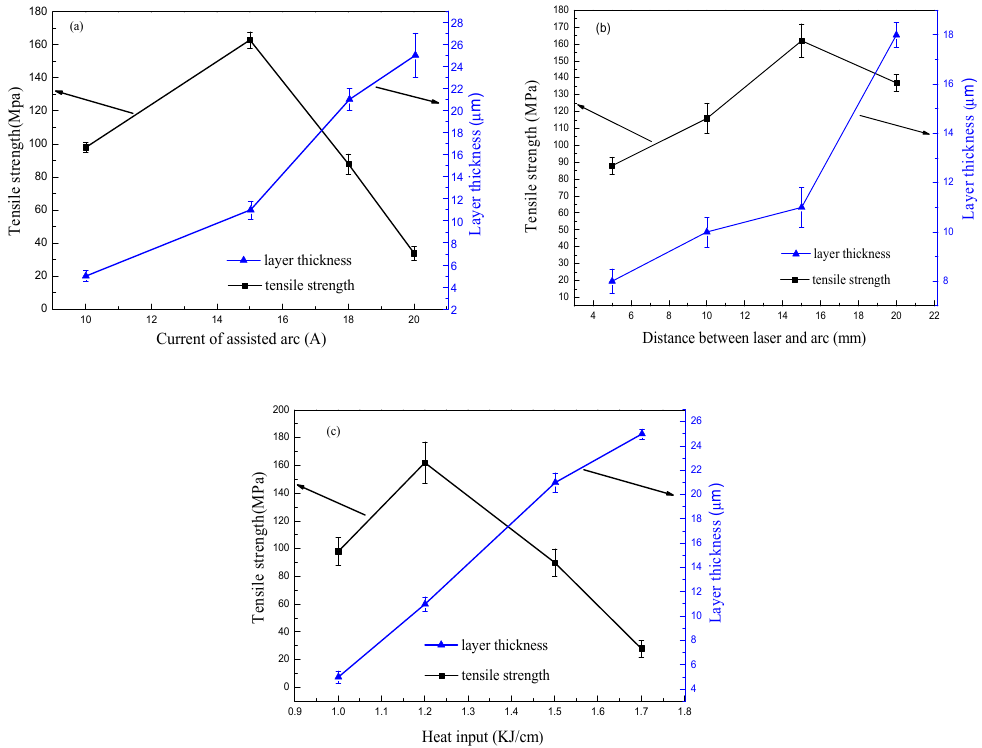
Figure 14. Effects of welding parameters on the IMC layer thickness and the tensile strength of the butt joint: ( a ) effects of assisted arc current, ( b ) effects of distance between heat source, ( c ) effects of heat input.